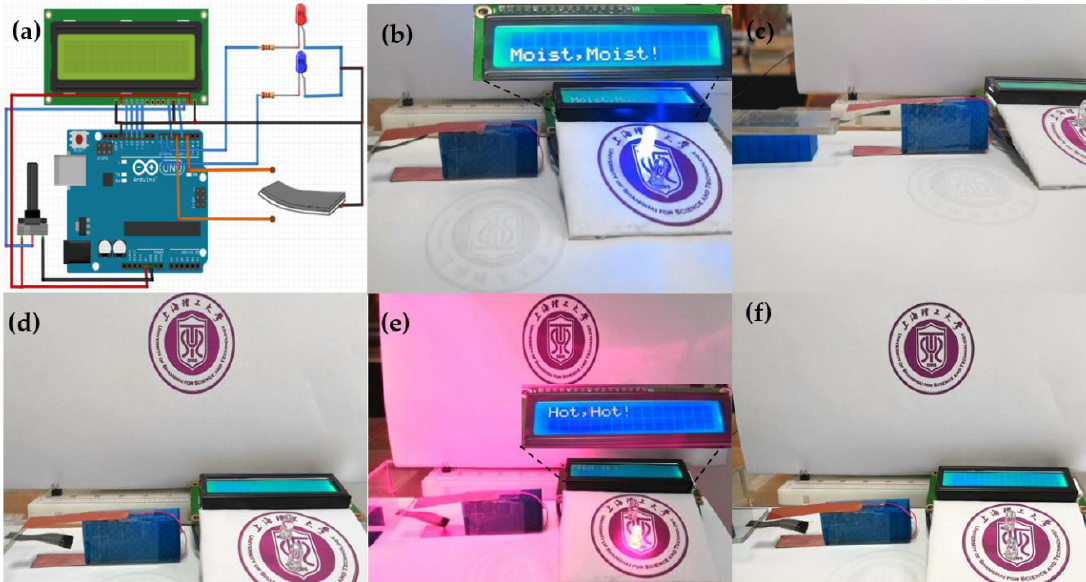
Figure 6. Optical and humidity-responsive switches. ( a ) Schematic of the membrane-based switch circuit. ( b – c ) The response of LED and LCD in a humid environment. ( d ) The original state of the switch based on actuator in the circuit. ( e – f ) The response of LED and LCD in the photothermal environment.